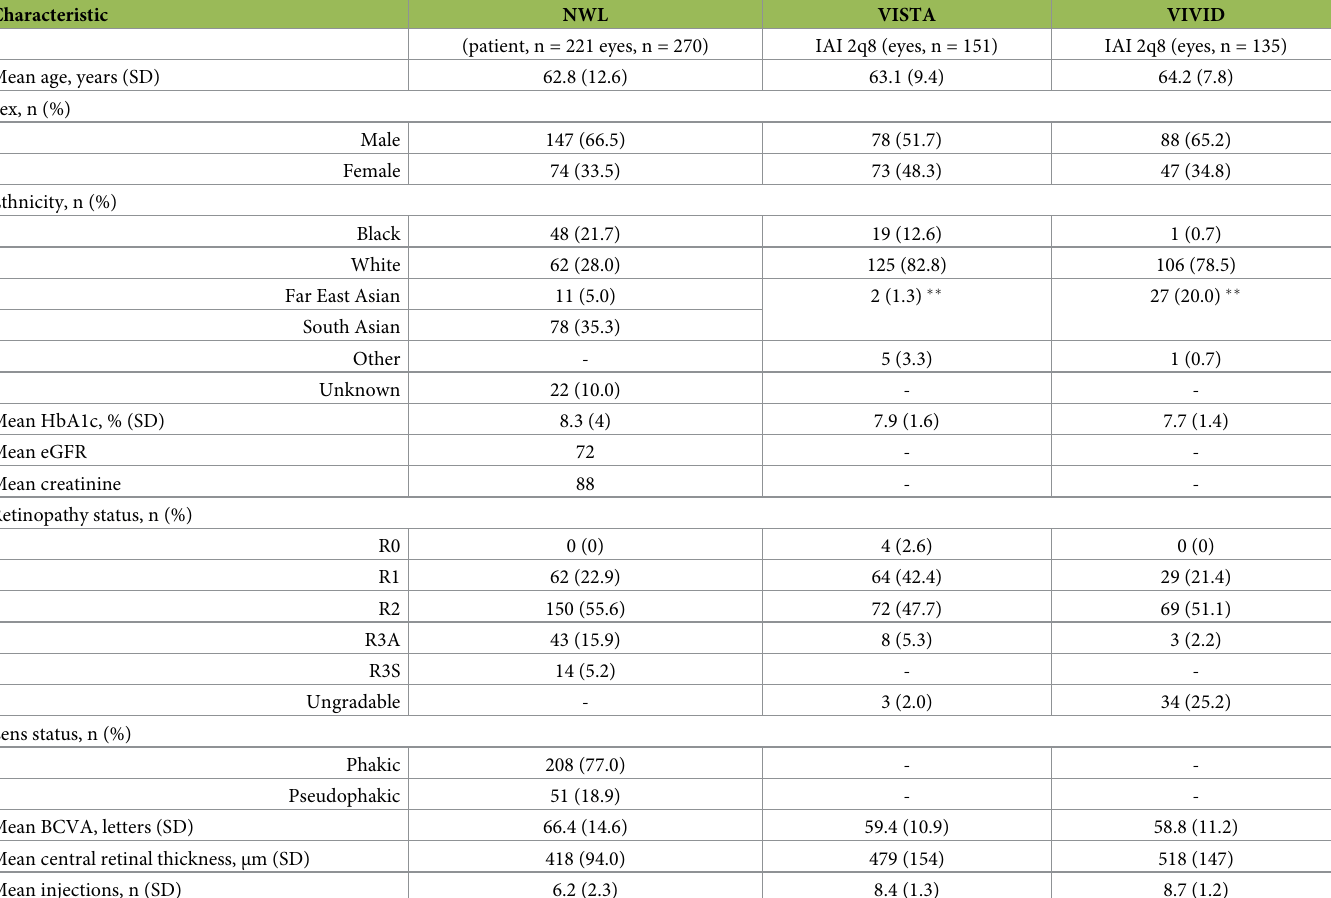
Table 1. Patient demographics and baseline characteristics and comparison to VIVID and VISTA participants.